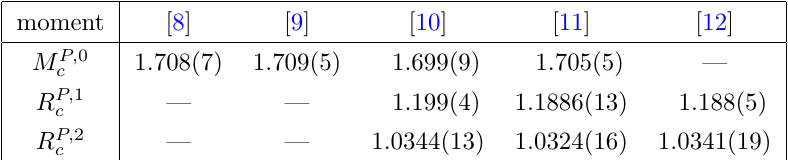
Table 7 . Lattice results for the 0-th moment (second row) and the ratios of moments (rest of rows) for the charm pseudo-scalar current correlator. We show the results for various lattice collaborations in di(cid:11)erent columns. These quantities are